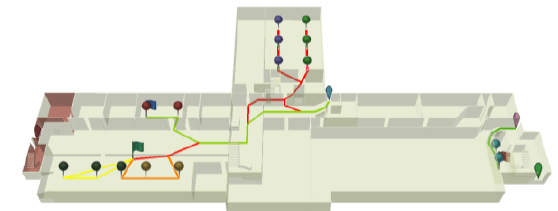
Figure 24. Generated Evacuation Basement Routes of Library Staff for First Evacuation Scenario